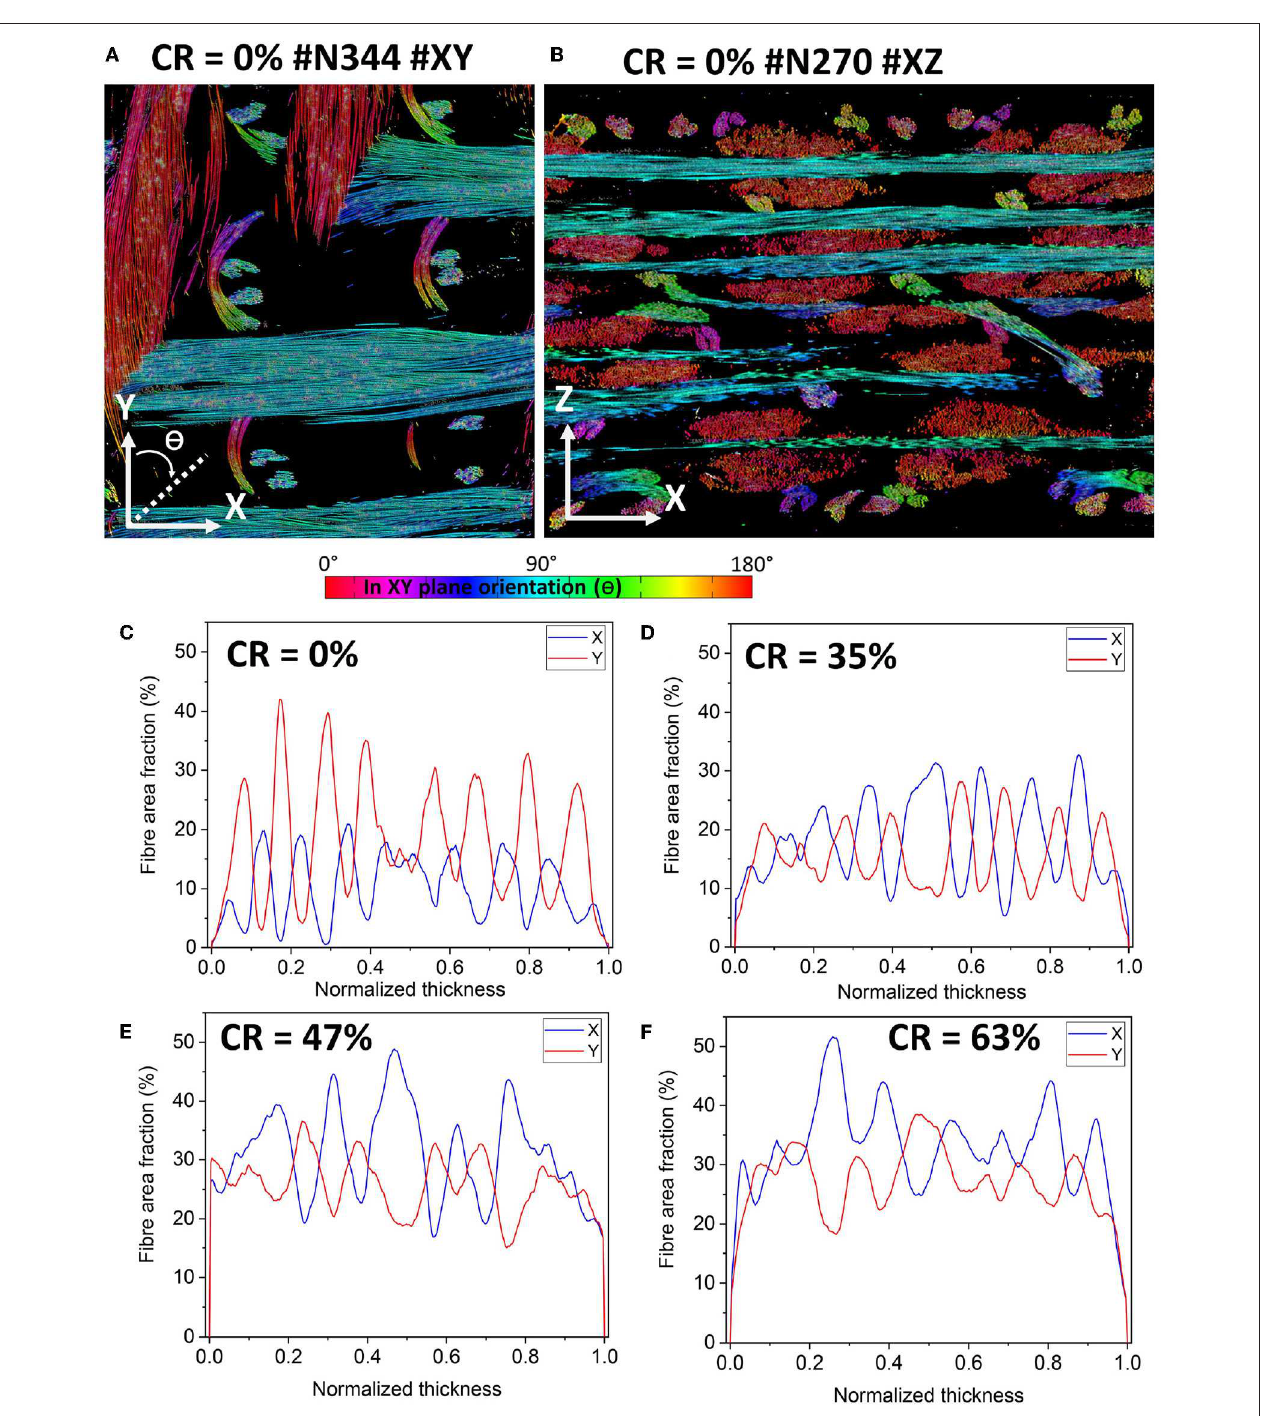
FIGURE 9 | (A,B) Color coded glass fiber orientations from µ CT 3D images which were segmented using the WCT method. (C–F) Fiber area fraction distributions along the Z direction with glass filaments aligned in the X and Y directions.